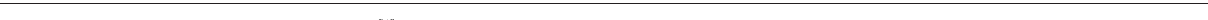
FIGURE 3 | (AMPAR)-EPSCs in Emx1-Cre;Irsp53 fl / fl layer V pyramidal neurons in the prelimbic region of the mPFC (2 months; male). n = 9 neurons for three mice for f/f, 11, 3 for Emx1, ns, not significant, Student’s t -test, t = 0.2447, df = 18. (D) Increased ratio of evoked EPSCs and IPSCs in Emx1-Cre;Irsp53 fl / fl layer V pyramidal neurons in the prelimbic region of the mPFC (2 months; male). n = 8 neurons for three mice for f/f, 8, 3 for Emx1, *** P < 0.001, Student’s t -test, t = 5.019, df = 14. (E) Normal paired-pulse ratio in Emx1-Cre;Irsp53 fl / fl layer V pyramidal neurons in the prelimbic region of the mPFC (2 months; male). n = 10 neurons for three mice for